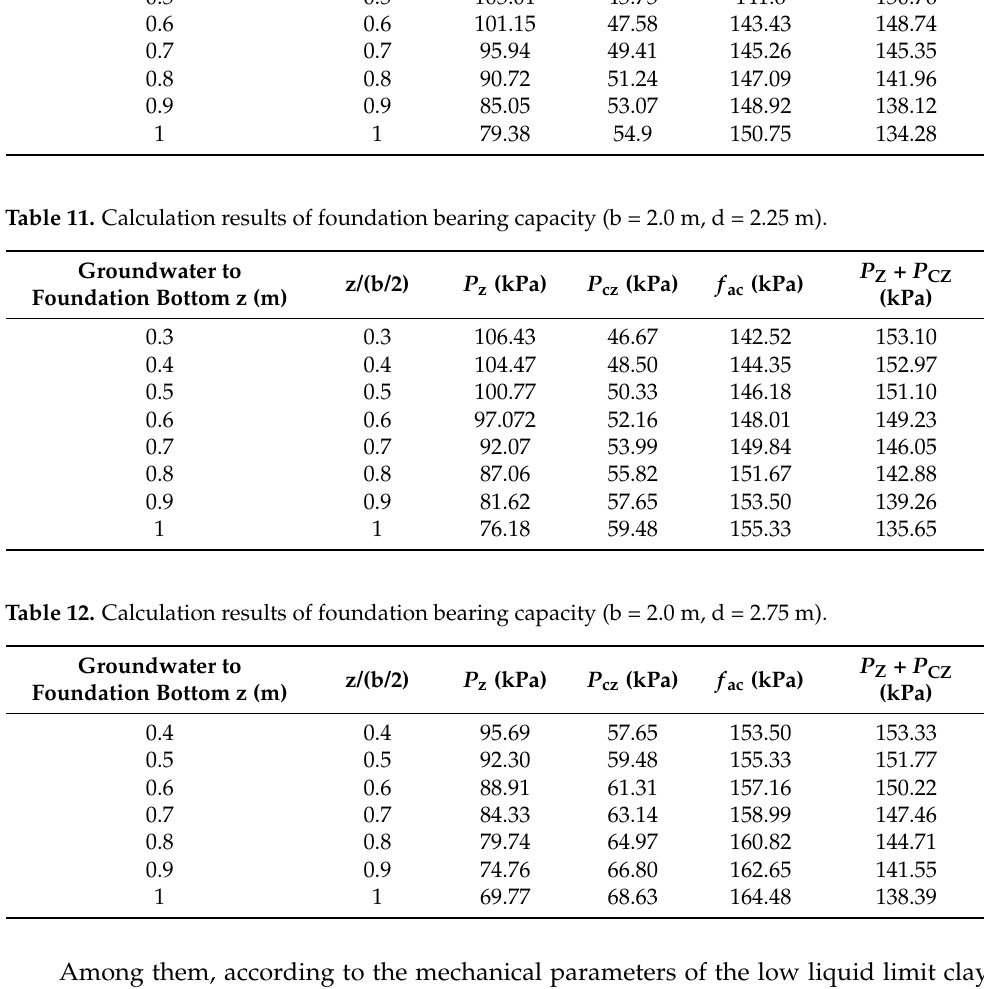
Table 10. Calculation results of foundation bearing capacity (b = 2.0 m, d = 2.0 m). Groundwater to Foundation Bottom z (m)